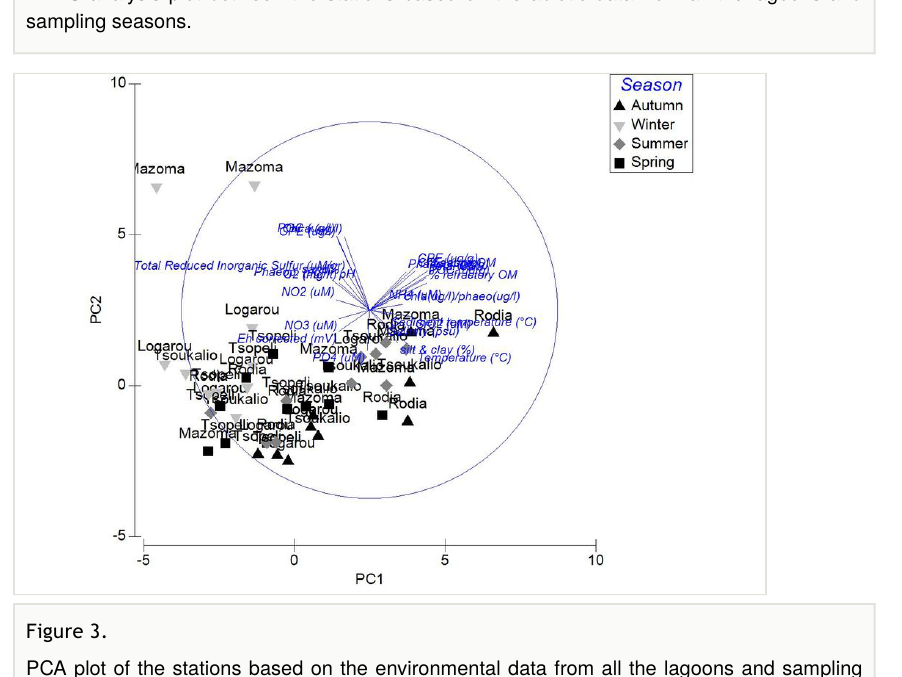
PCA plot of the stations based on the environmental data from all the lagoons and sampling